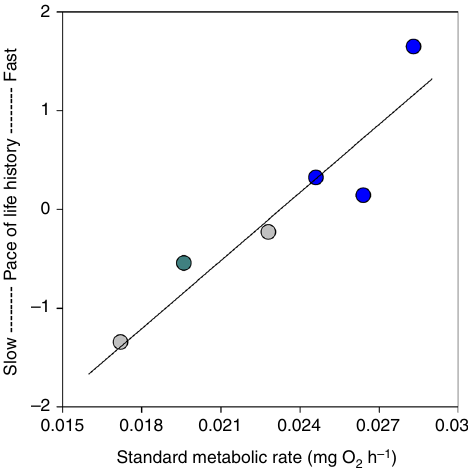
Fig. 3 Standard metabolic rate covaries with the pace of life history. Standard metabolic rate was positively correlated with a suite of life history traits across six populations (Pearson correlation: P = 0.007). Included are naturally occurring populations with fast-paced (blue, n = 3) and slow- paced life histories (gray, n = 2) and a population transplanted from a high- to low-predation site 35 years ago that has since evolved a slow-paced life history (green, n = 1). The pace of life history was determined using principal component analysis (PCA) of estimates for the suite of traits including male age and mass at maturity, female age and mass at fi rst parturition, inter-litter interval, and reproductive allotment. The fi rst principle component (plotted on the y axis) had an eigenvalue of 3.70, explained 61% of the variation in life history traits, and differentiated populations with later maturity and lower reproductive investment (lower scores) from those with earlier maturity and higher reproductive investment (higher scores). Values for standard metabolic rate were standardized to a common body mass of 74 mg prior to analysis (mean across all fi